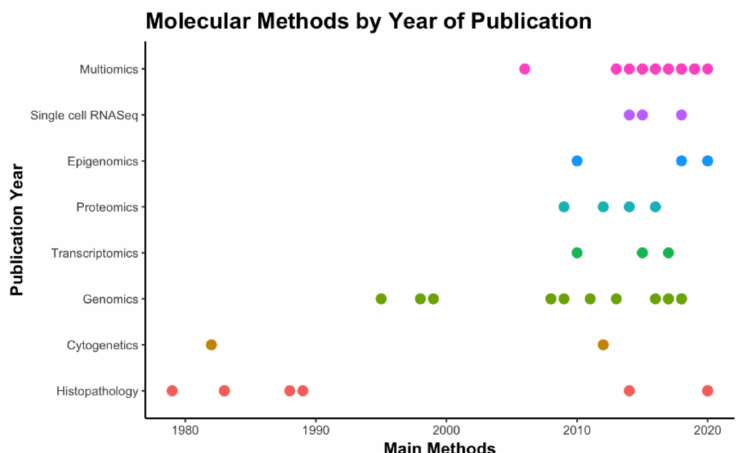
Figure 2. Timeline of methods by year of publication based on the articles selected in this re- view. “Histopathology” = H&E and IHC stains (the 1st WHO classification is from 1979). “Multi- omics” = studies with independent results from two or more high-throughput methods; studies with multiple methods for determination of groups in the study were not included in this